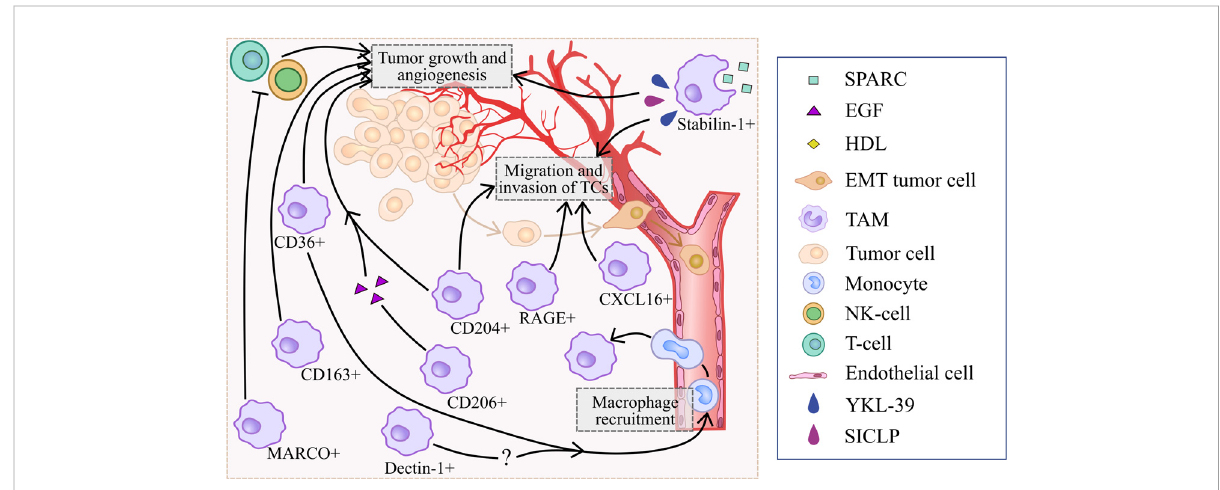
FIGURE 3 Summary of processes that are regulated by scavenger receptors in tumor-supporting